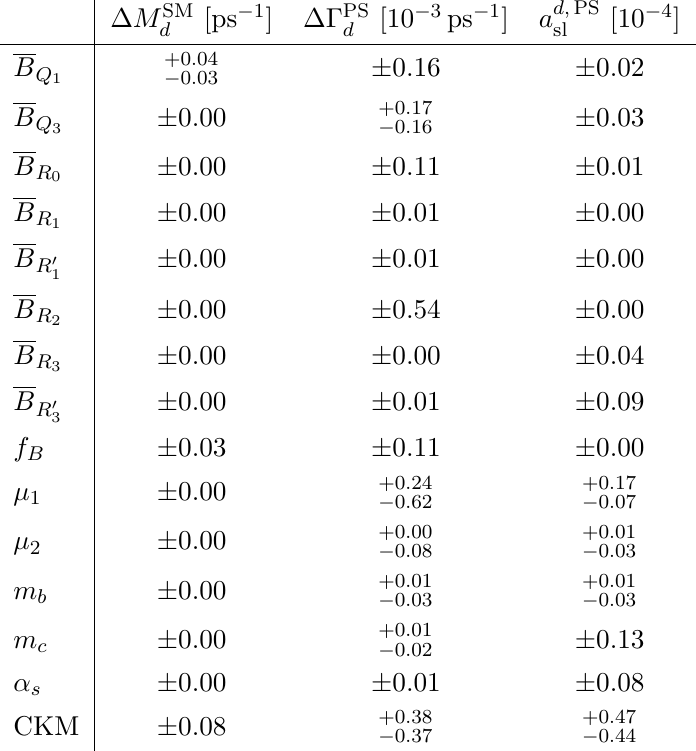
Table 7 . Individual errors for the B d mixing observables.